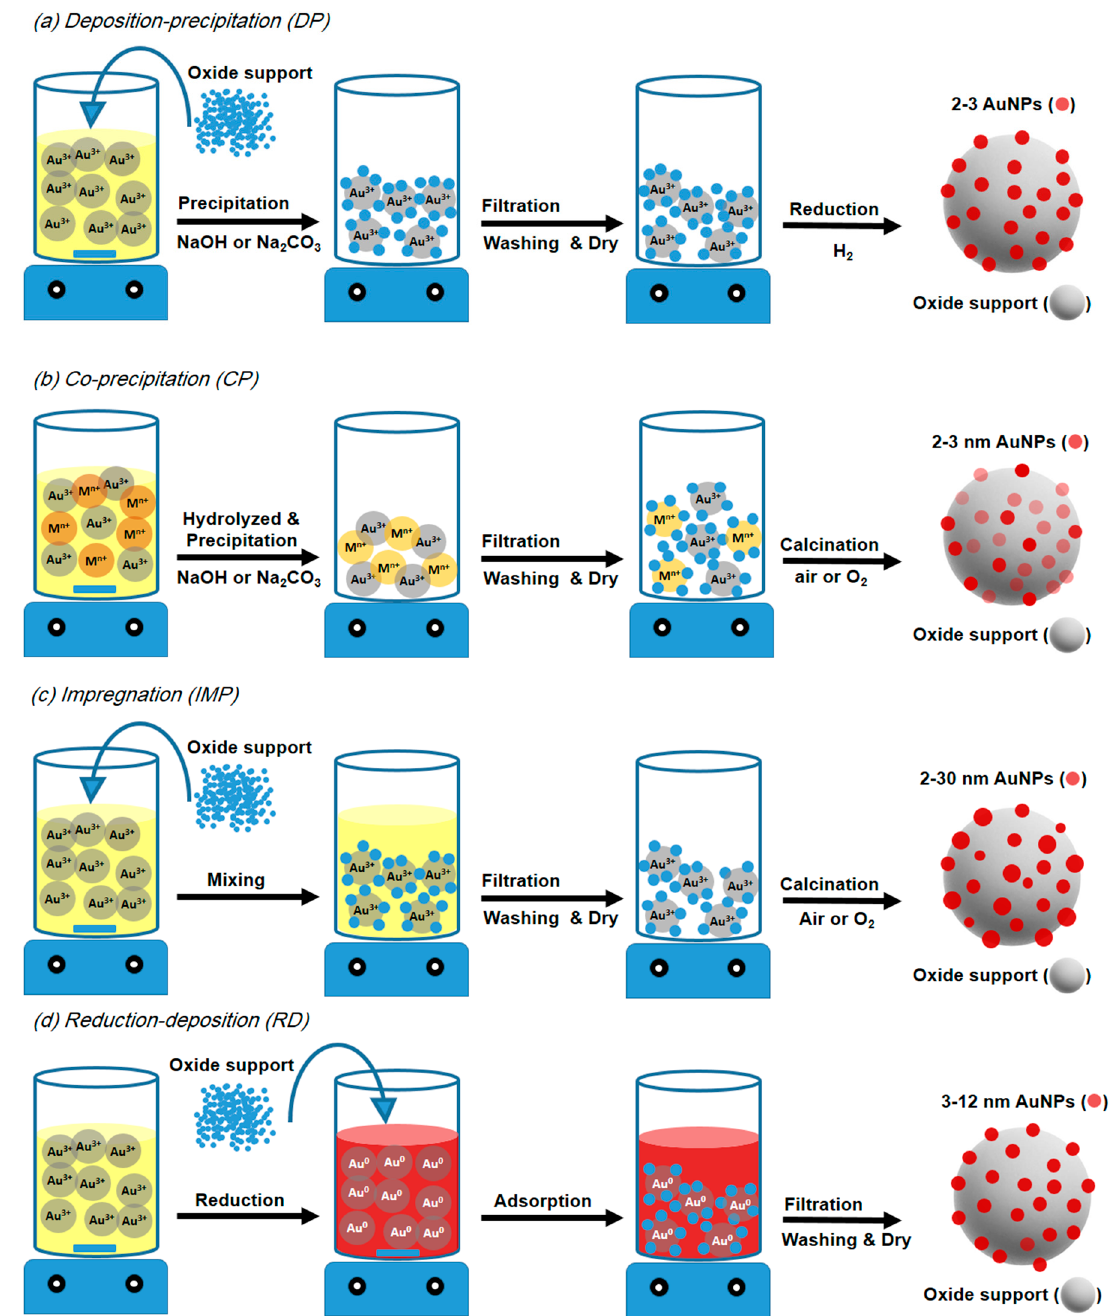
Figure 2. Schematic illustration of the preparation of gold catalyst via deposition-precipitation ( a ), co-precipitation ( b ), impregnation ( c ), and reduction-deposition ( d ) methods.